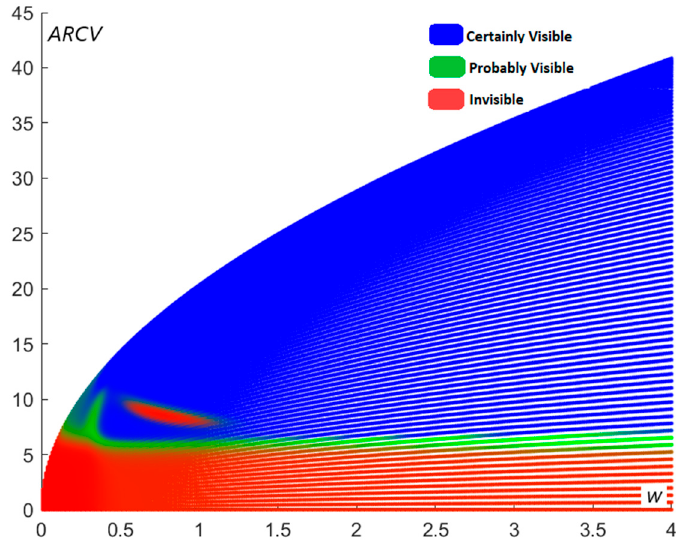
Figure 5. Performance of the Pattern Recognizer ANN for a test data.